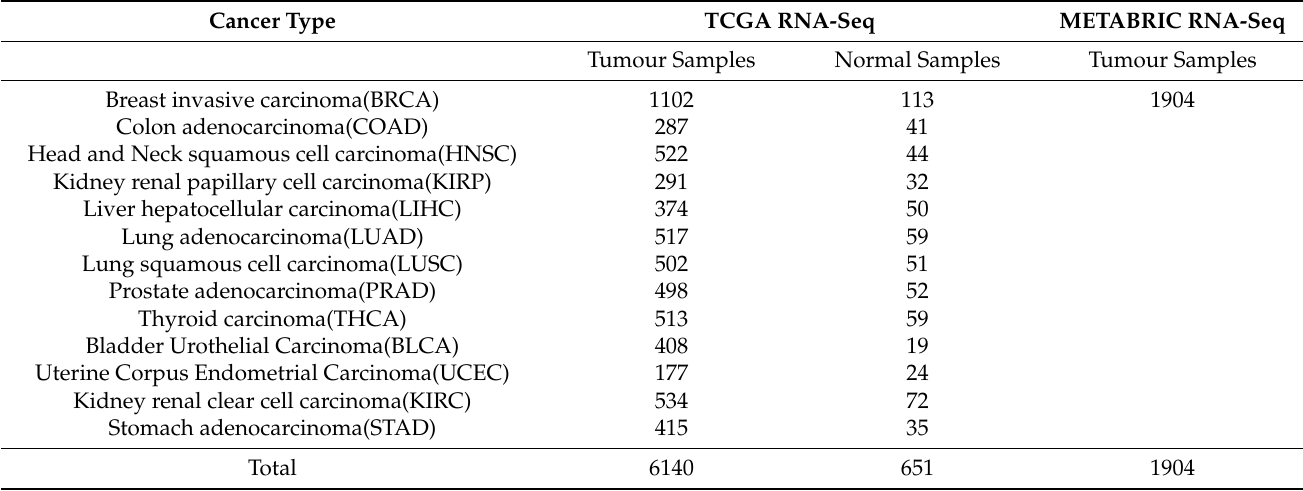
Table 1. The numbers of samples of 13 types of cancer downloaded from the TCGA and METABRIC databases. Cancer Type TCGA